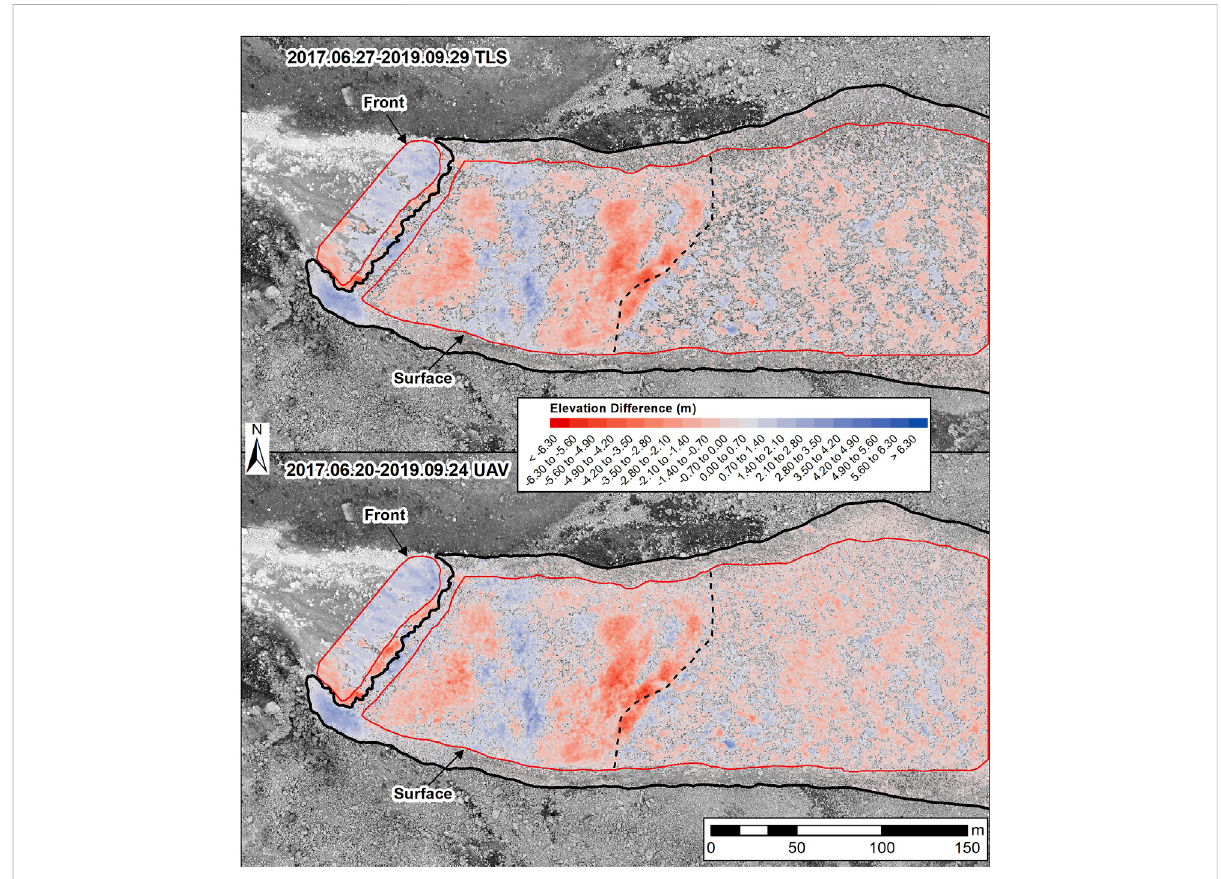
FIGURE 7 Elevation difference analysesusing TLS (upper) and UAV (lower) datasets for 2017 – 2019. Black dashed lines correspond to the scarp position in 2017. The background image is a UAV-derived orthomosaic from September 2019.